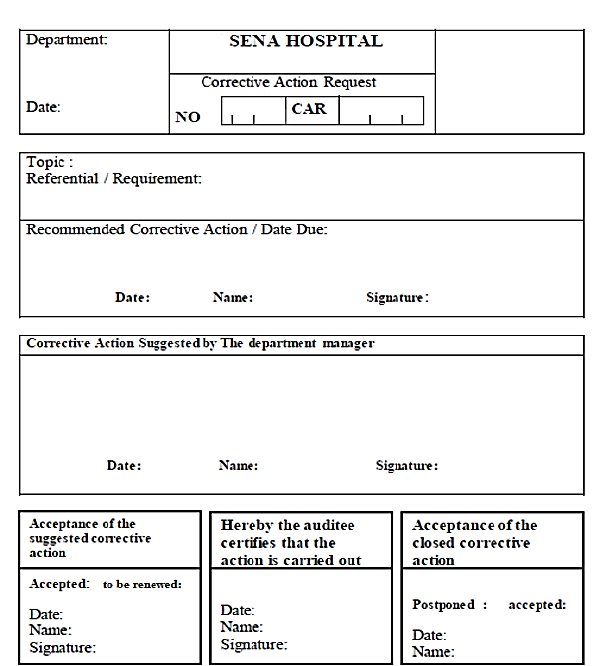
Fig. 2. Non-conformance form.